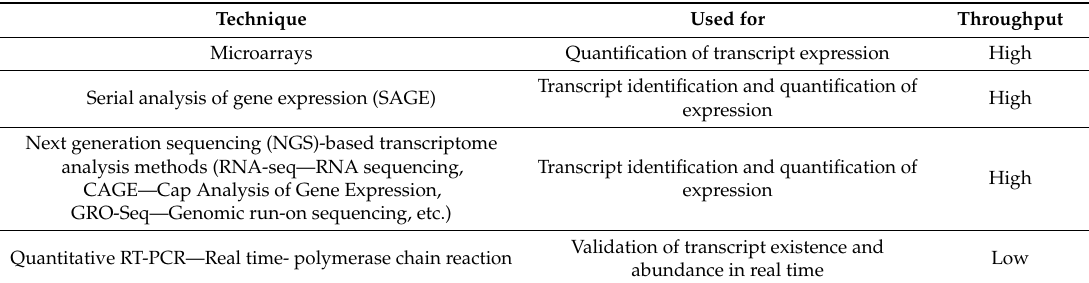
Table 4. Experimental techniques available for the identification, quantification, and characterization of ncRNAs. Technique Used for Throughput